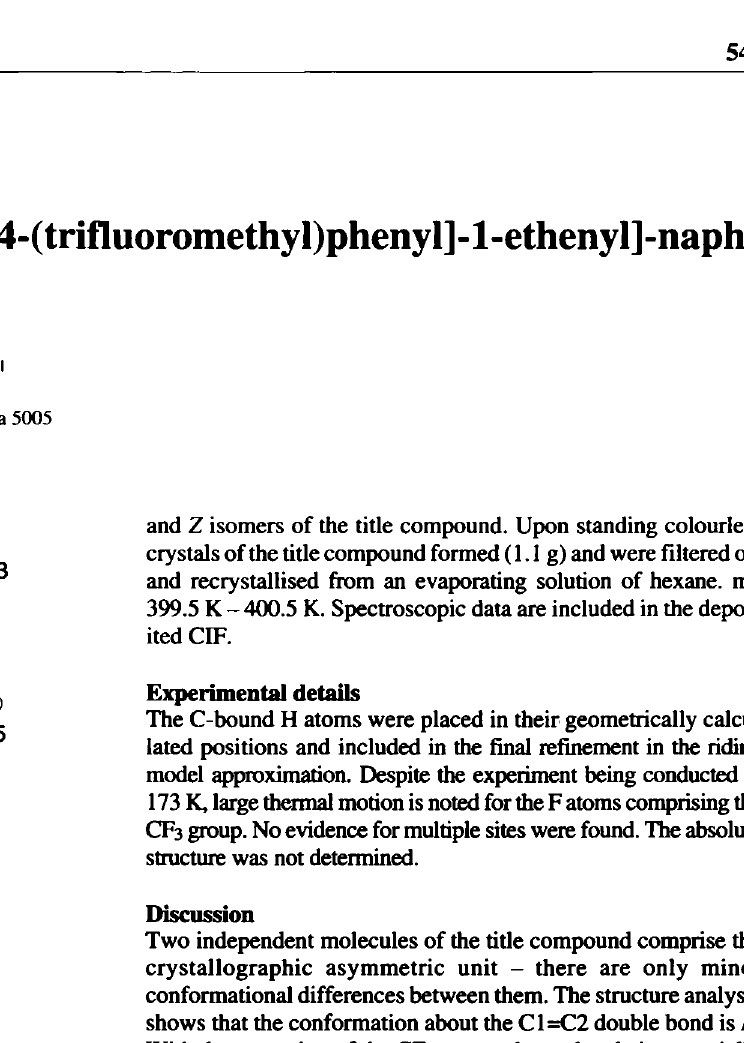
Table 1. Data collection and handling.